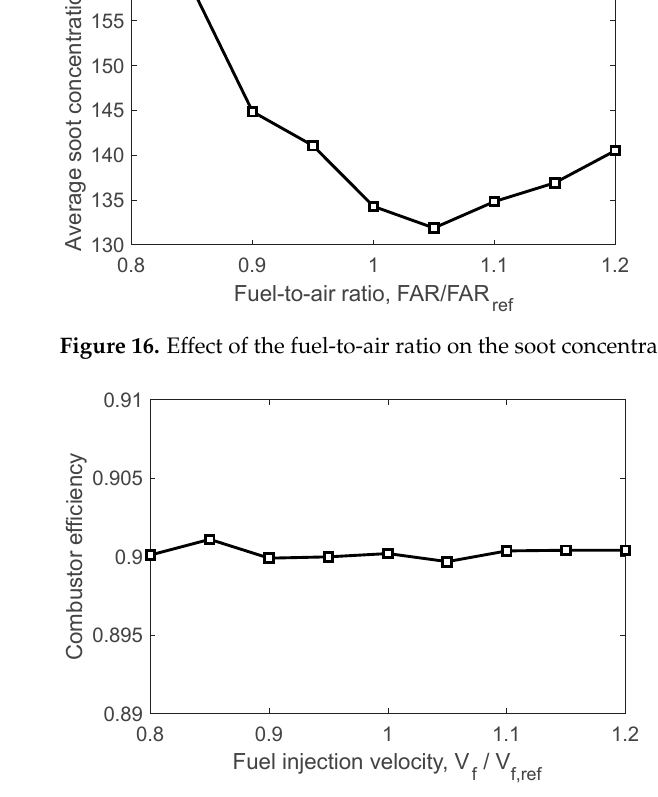
Figure 16. E ff ect of the fuel-to-air ratio on the soot concentration.